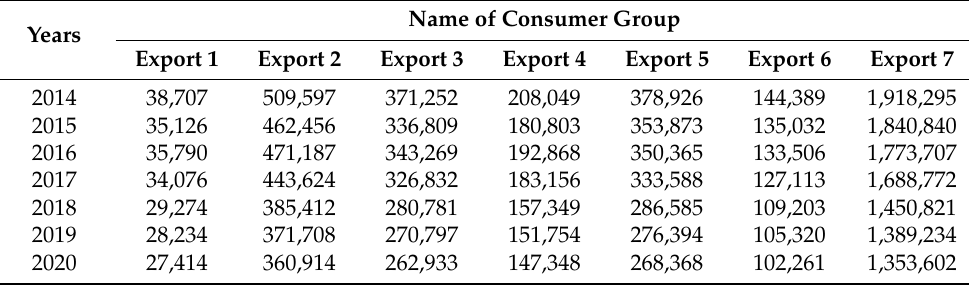
Table A1. The historical volumes of coal demand from the “Export” consumers in the years 2014– 2020,